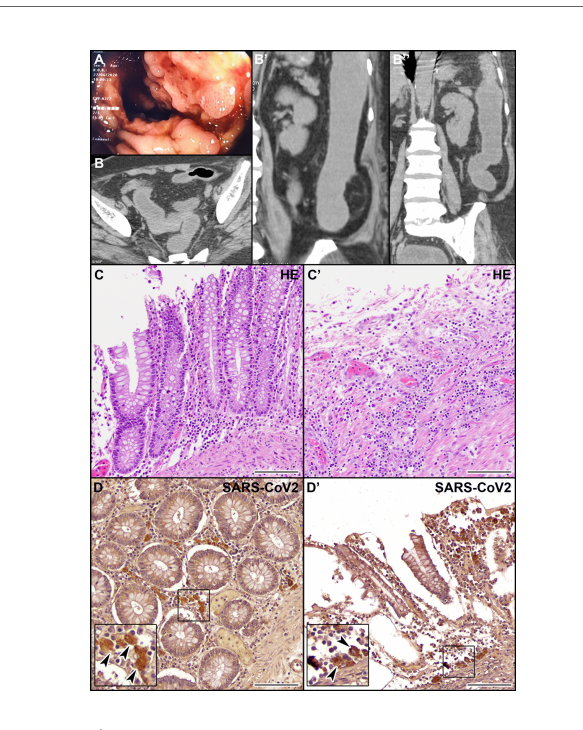
FIGURE 2 | Endoscopic, CT, histological, and immunohistochemical (IHC) examination of the patient ’ s colon. (A) Endoscopic picture of the colon showing very severe in fl ammation with diffuse pseudopolyposis and ulcers. (B, B ’’ ) CT scan of the abdomen in coronal (B) and axial (B ’ , B ’’ ) planes reveals a stove-pipe colon with thinned wall and comb sign of the vasa recta indicative of acute in fl ammation. The rectum appears normal. (C, C ’ ) Hematoxylin-eosin staining of non-ulcerated (C) and ulcerated (C ’ ) areas of the colon mucosa. (D, D ’ ) IHC localization of SARS-CoV-2 virus in macrophages (arrowheads) in the non-ulcerated (D) and ulcerated (D ’ ) colon mucosa. Scale bars: 100